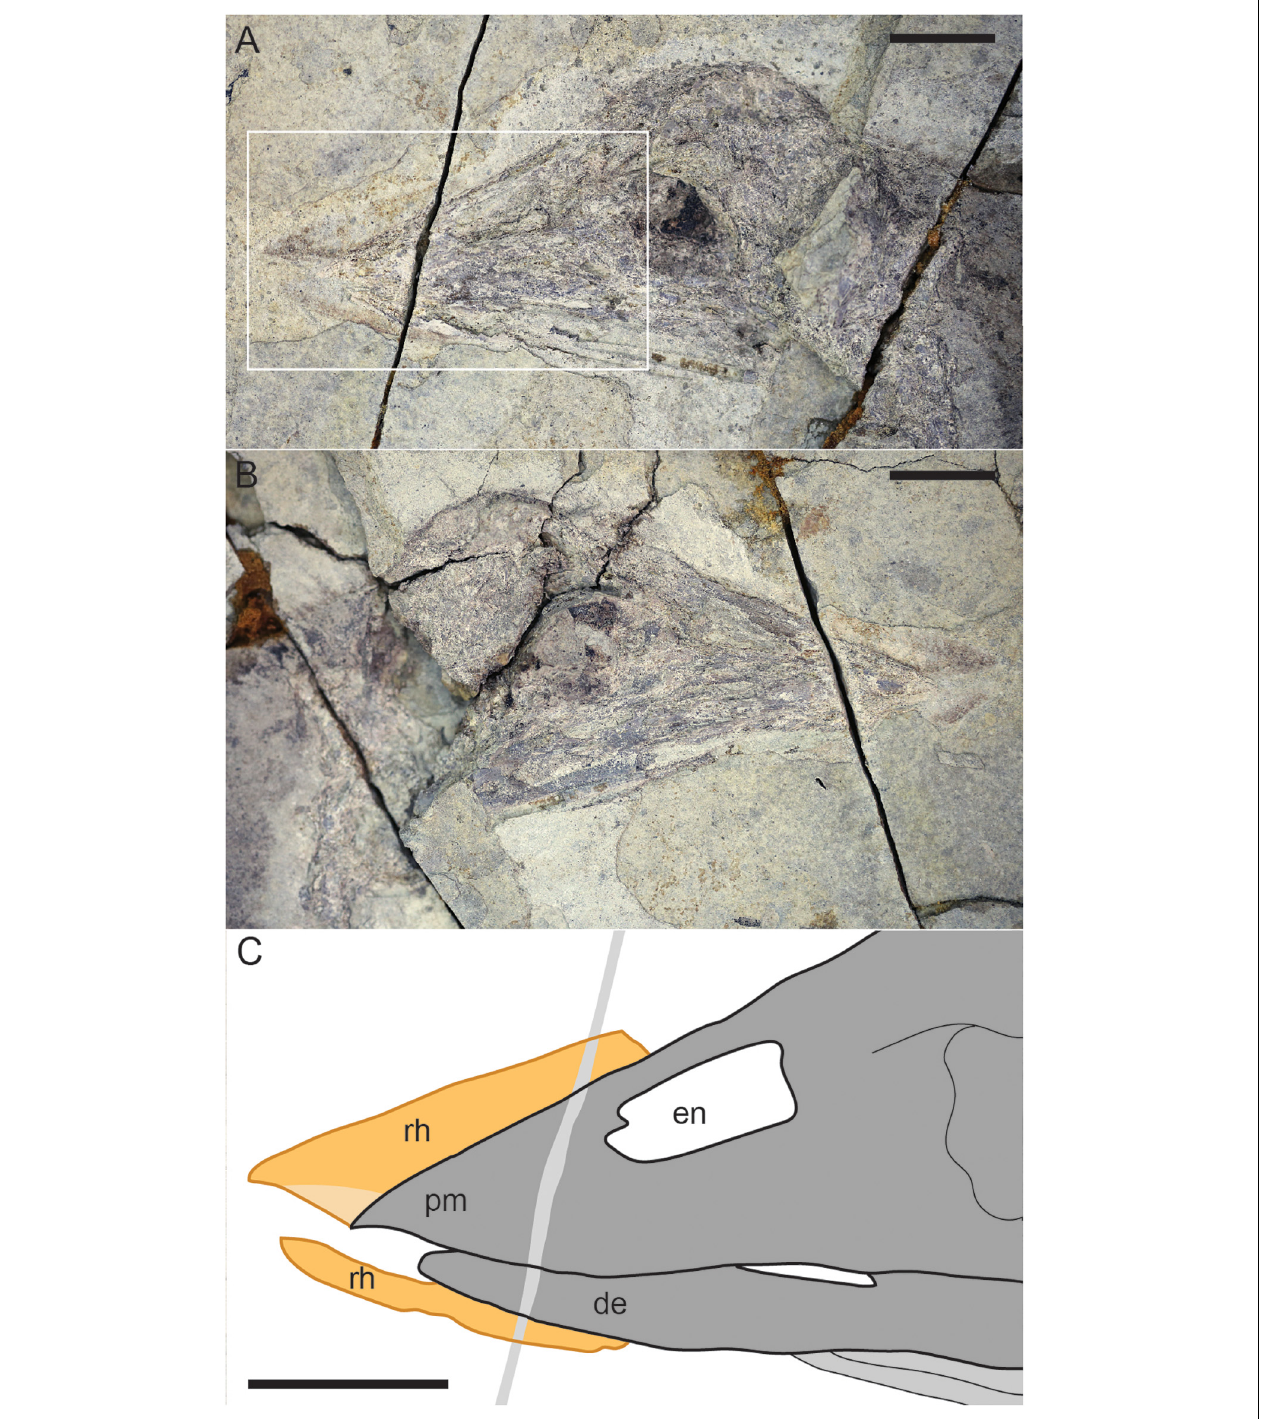
FIGURE 4 | Close up of the skull of Confuciusornis STM13-162: (A) photograph of slab; (B) photograph of counter slab; (C) interpretative drawing. Scale bars equal one centimeter. For anatomical abbreviations see Figure 3 caption.